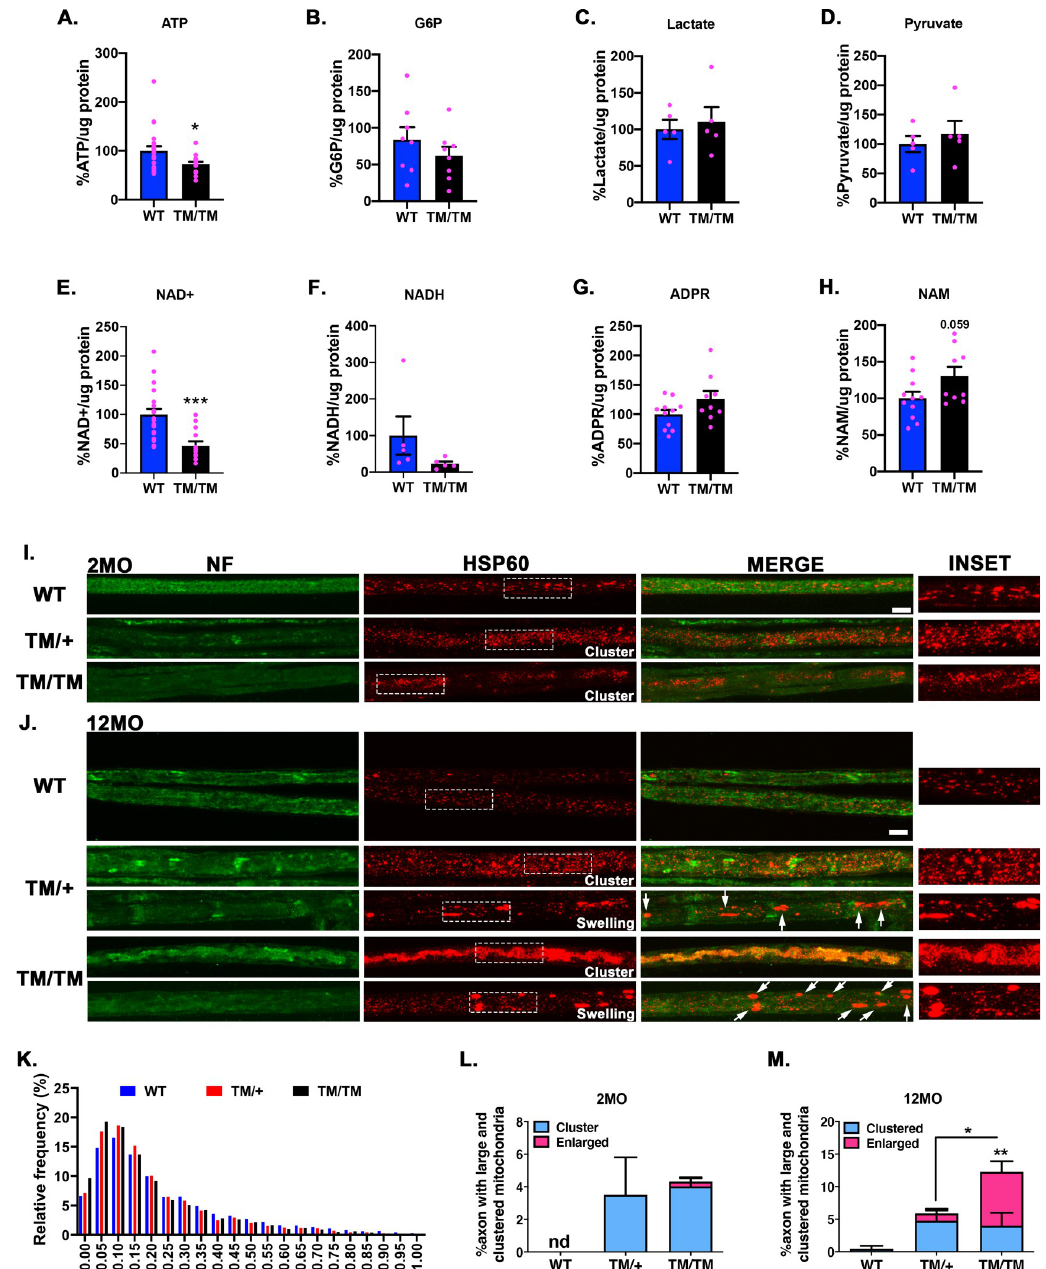
Fig 8. Metabolic and axonal mitochondrial impairments in Mpz T124M mice. ( A to H ) Measurements of metabolites involved in axonal energy and degeneration programs. ATP ( A ), G6P ( B ), lactate ( C ), pyruvate ( D ), NAD + ( E ), NADH ( F ), ADPR ( G ), and NAM ( H ) were quantified via liquid chromatography-tandem mass spectrometry of sciatic nerves from 12-month-old mice. n (animals) � 5 per genotype. ( I and J ) Representative confocal pictures of sciatic nerve teased fibers stained with antibodies against mitochondrial protein HSP60 (red) and axonal marker neurofilament (NF) (green) from mice at 2 ( I ) and 12 ( J ) months of age. Arrows indicate swelled mitochondria. Scale bars: 10 μ m. High magnification insets show mitochondria. ( K ) Relative frequency distributions of mitochondrial surface area ( μ m 2 ) at 2 months of age. Nodal length Surface area was quantified from at least 1,096 mitochondria per animal. Proportions of axons with clustered and enlarged mitochondria at 2 ( L ) and 12 ( M ) months of age. One-way ANOVA [clustered mitochondria at 2 month old: F (2,6) = 2.558, p = 0.1573 and at 12MO month old: F (2,7) = 1.812, p = 0.2322; enlarged mitochondria at 12 month old F (2,7) = 14.43, p = 0.0033]. At least 263 axons per genotype were imaged. n (animals) � 3 per genotype. � p < 0 . 05 , �� p < 0 . 01 , ��� p < 0 . 001 by two-tailed Student’s t test ( A to H ) and by multiple- comparisons Tukey’s post hoc tests after one-way ANOVA ( K to M ). Graphs indicate means ± SEMs.